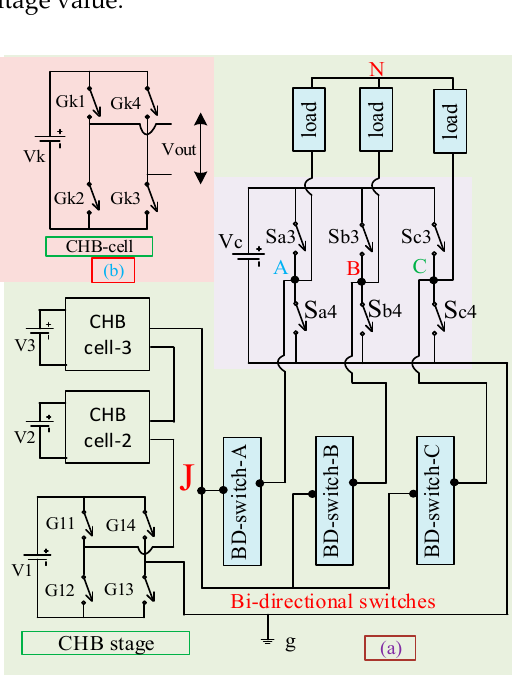
Figure 4. Proposed three-phase CMLI ( a ) CHB cells are considered as cascaded stage; ( b ) a standard CHB cell. Reprint with permission [4261051118814]; 2018, IEEE.